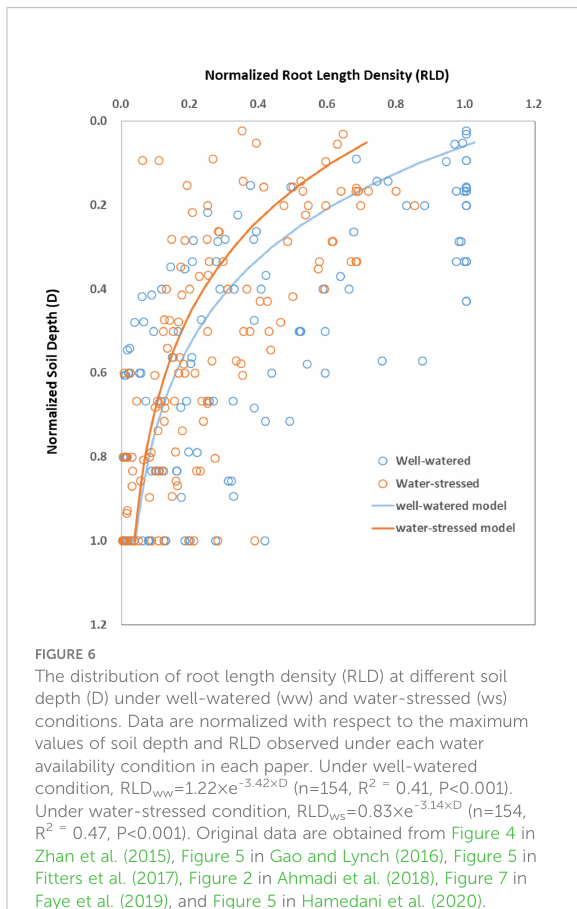
FIGURE 6 The distribution of root length density (RLD) at different soil depth (D) under well-watered (ww) and water-stressed (ws) conditions. Data are normalized with respect to the maximum values of soil depth and RLD observed under each water availability condition in each paper. Under well-watered condition, RLD ww =1.22×e -3.42×D (n=154, R 2 = 0.41, P<0.001). Under water-stressed condition, RLD ws =0.83×e -3.14×D (n=154, R 2 = 0.47, P<0.001). Original data are obtained from Figure 4 in Zhan et al. (2015), Figure 5 in Gao and Lynch (2016), Figure 5 in Fitters et al. (2017), Figure 2 in Ahmadi et al. (2018), Figure 7 in Faye et al. (2019), and Figure 5 in Hamedani et al. (2020).